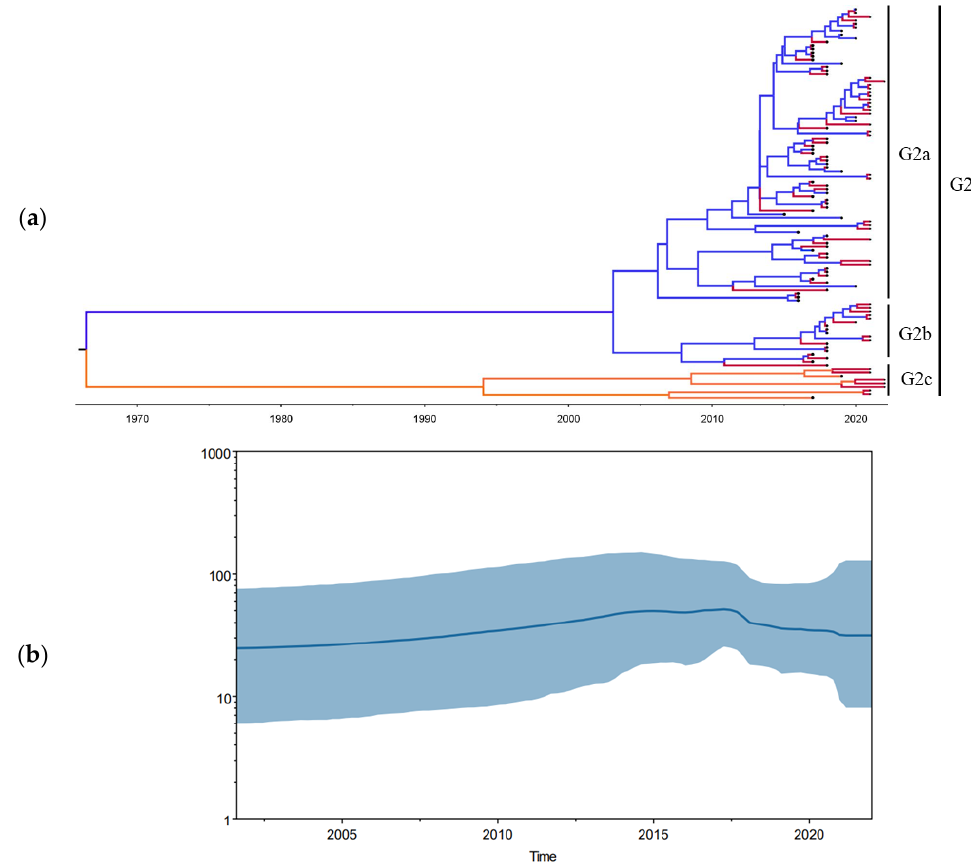
Figure 3. The maximum clade credibility (MCC) trees of the partial S1 gene sequences of PEDV strains found in Guangxi during 2015 – 2022. ( a ) The MCC tree was created using BEAST version 1.8.3 software; the Guangxi PEDV strains are marked with red nodes. Bayesian skyline plot of partial S1 gene sequences of PEDV strains. ( b ) Dark blue lines represent mean value of genetic diversity; light blue shading represents 95% confidence intervals.